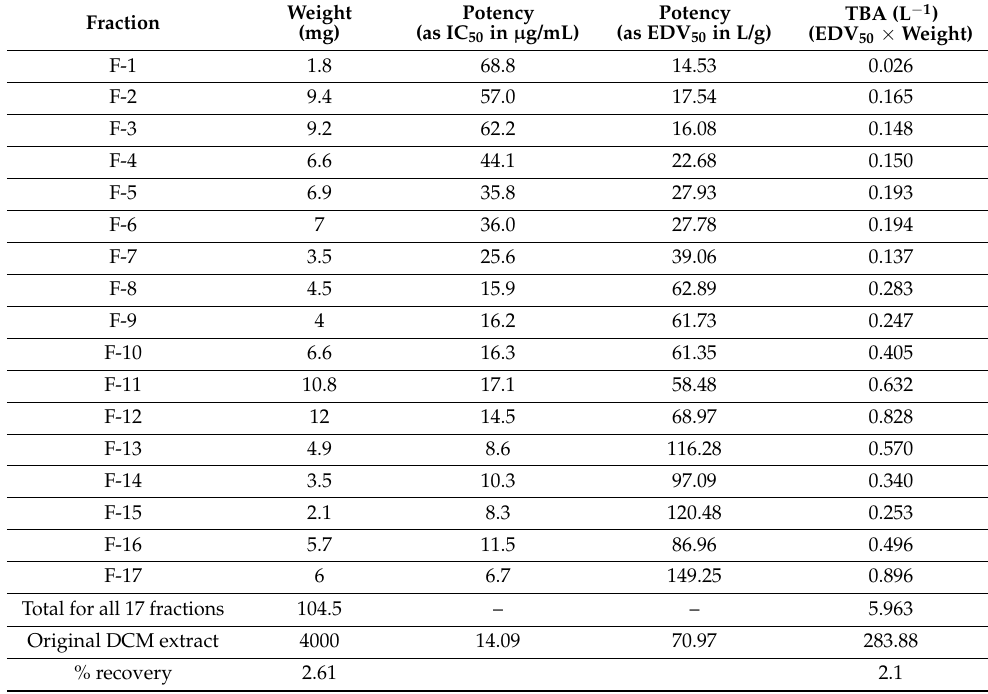
Table 3. Calculations for the TBA for purified HPLC fractions